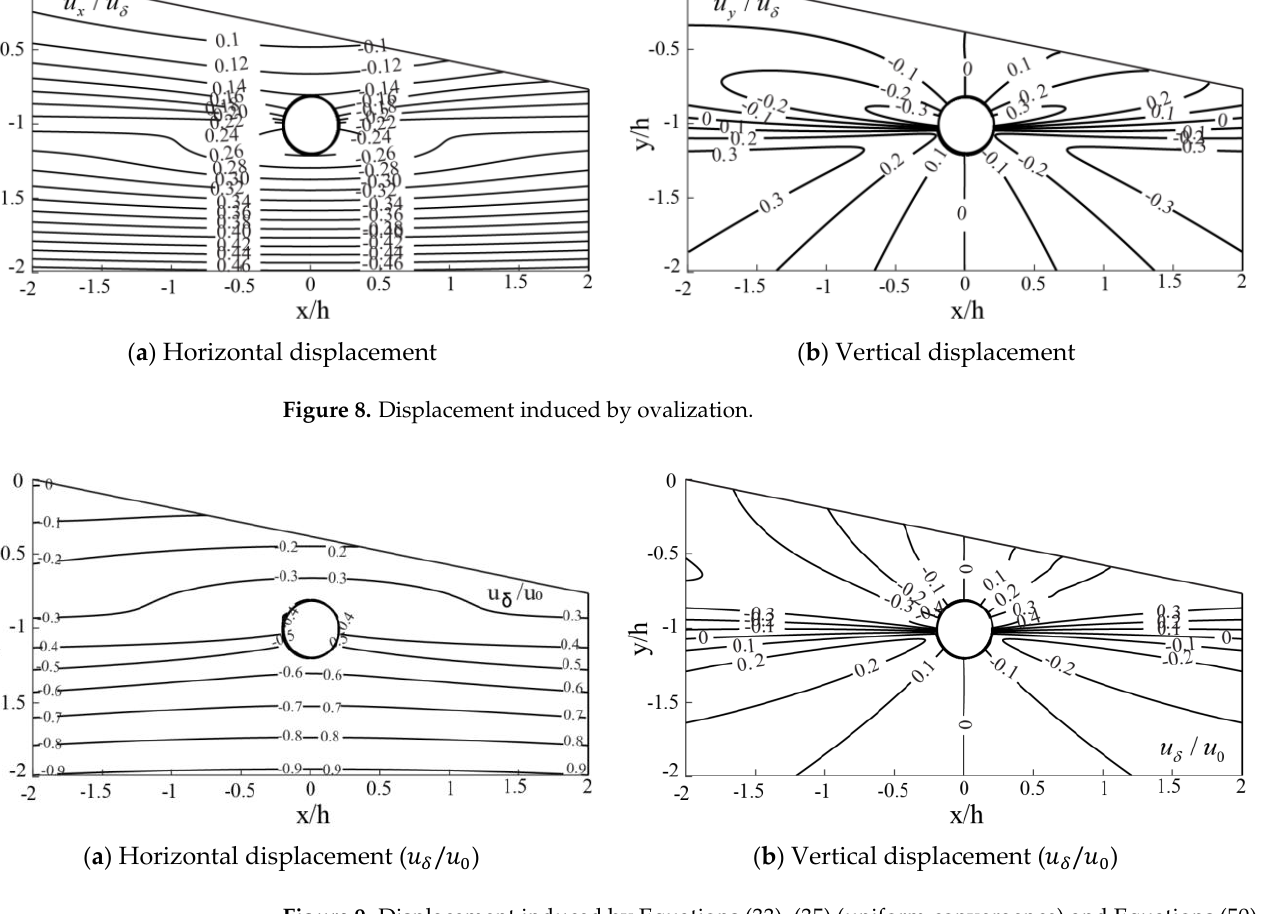
Figure 10. Vertical translation of the tunnel wall.